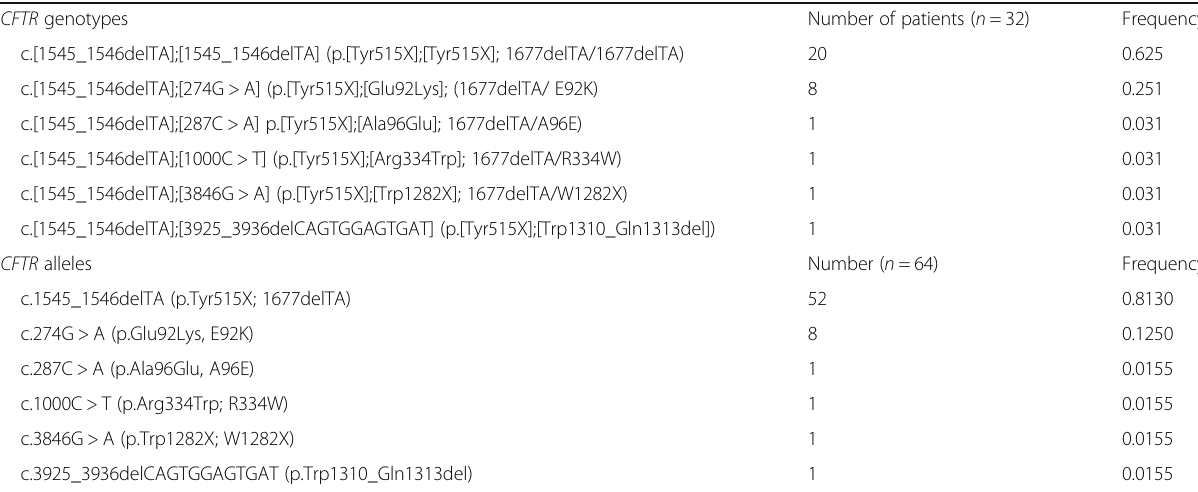
Table 1 Distribution of CFTR gene mutations in Chechen CF patients